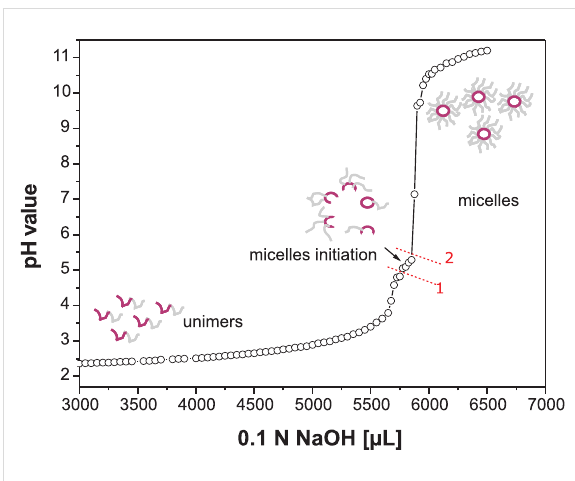
Figure 8: Titration of P2VP 105 - block -PNIPAAm 332 (1g/L) in 0.02 N HCl with 0.1 N NaOH at room temperature.